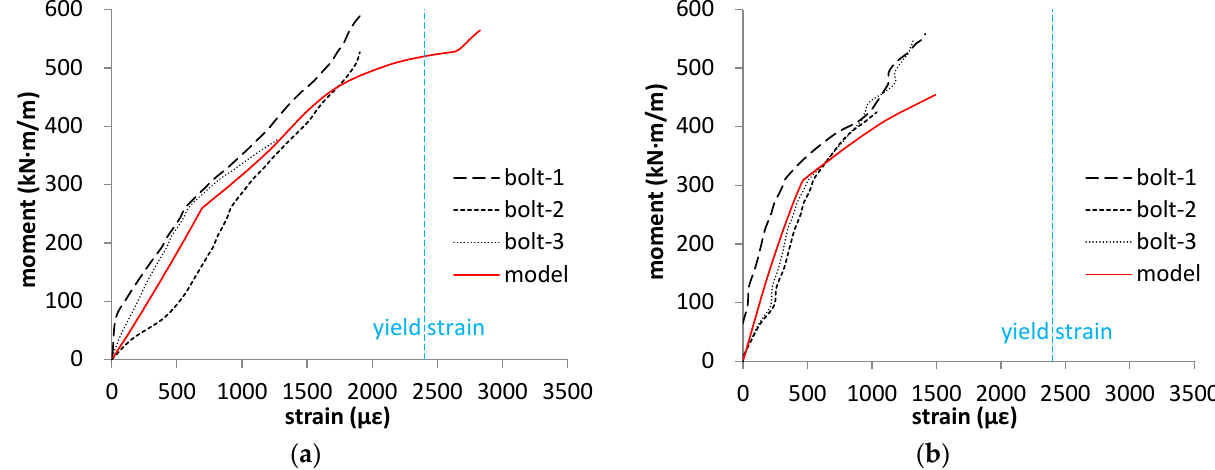
Figure 17. Evolution of the bolt strains with increasing bending moments: ( a ) Type-BPos joint in positive cases; ( b ) Type- BNeg joint in negative cases.